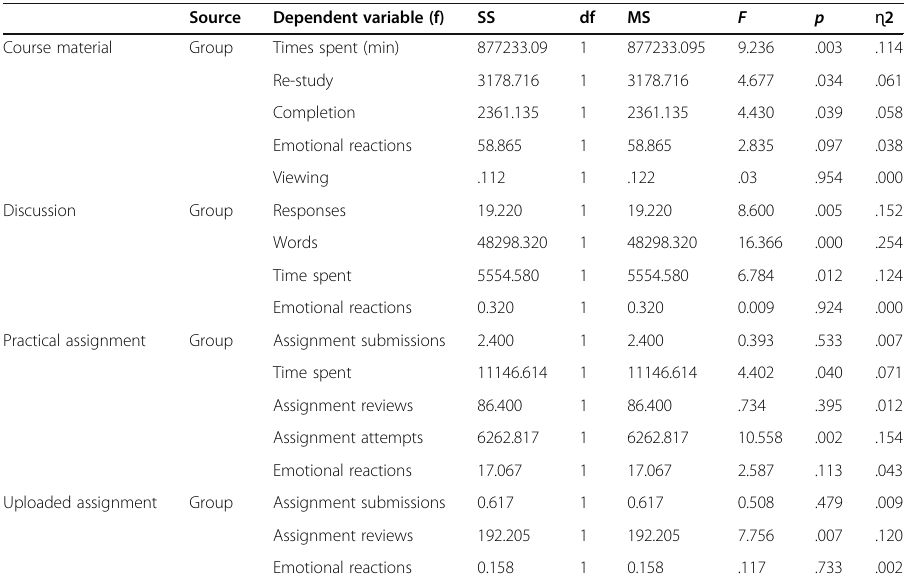
Table 6 Results of the ANOVA test for